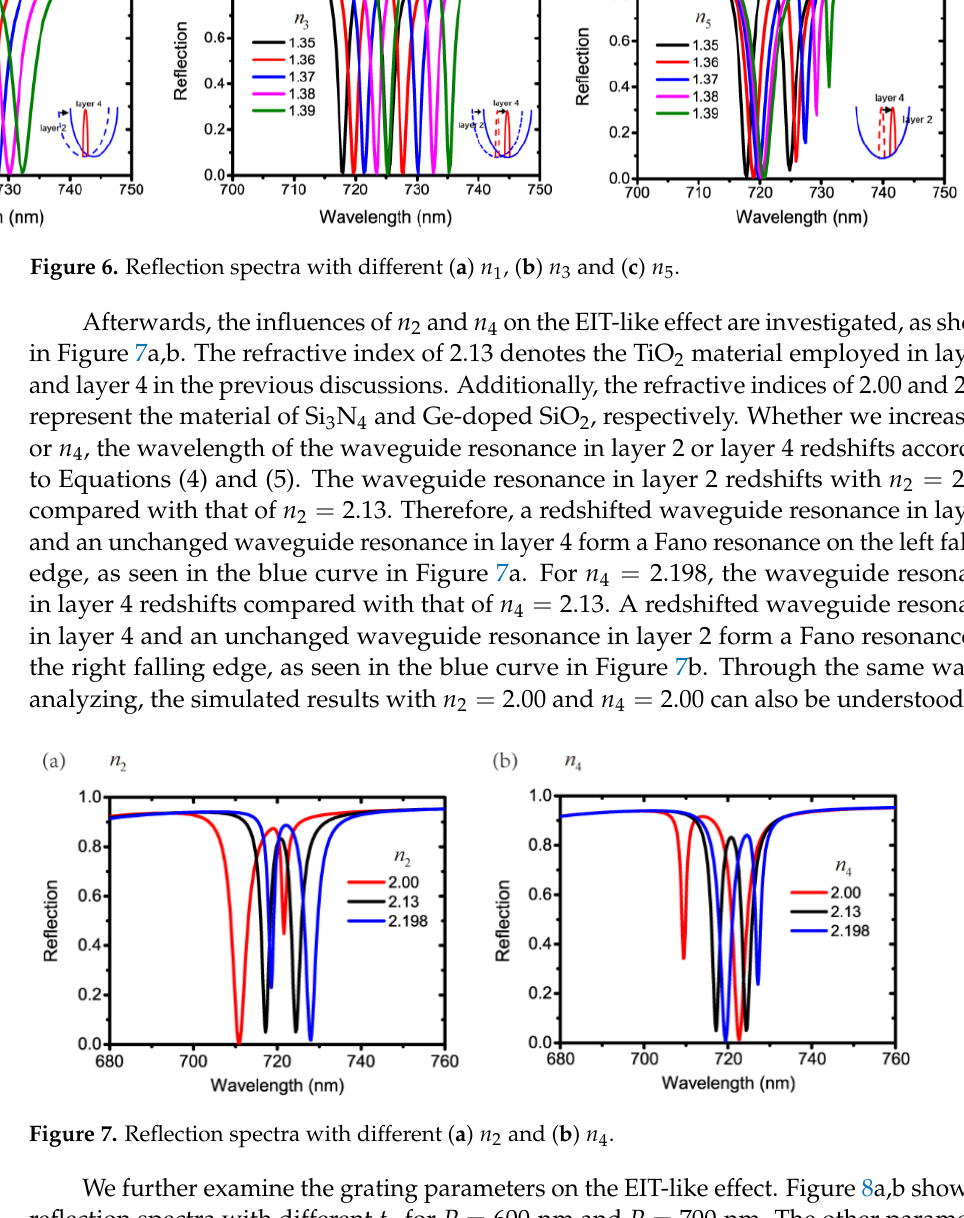
Figure 7. Reflection spectra with different ( a ) n 2 and ( b ) n 4 . We further examine the grating parameters on the EIT-like effect. Figure 8a,b show the reflection spectra with different t 1 for P = 600 nm and P = 700 nm. The other parameters are a = 400 nm, h = 50 nm, t 2 = 100 nm, t 3 = 640 nm and t 4 = 100 nm. Compared with P = 500 nm in Figure 1a, the EIT-like effect redshifts with an increasing P . The reason of the redshift of the EIT-like effect is explained as follows. When the grating period of P increases, the wavenumber of the SPPs resonance decreases according to Equations (2) and (3). The SPPs resonance excites the waveguide resonance, so the propagating constant β (cid:48) of